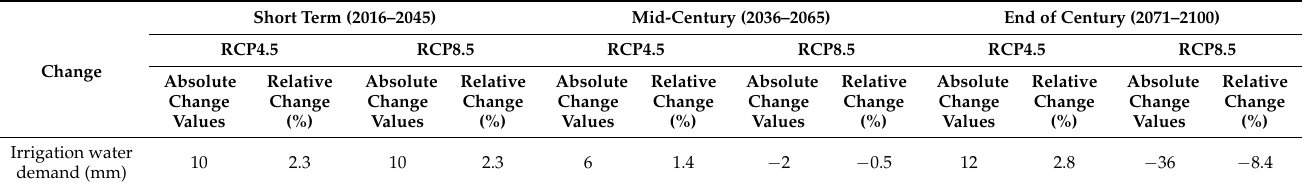
Table 4. Absolute and relative change in irrigation water demand, biomass, and grain yield for wheat based on average values from four GCMs relative to the reference period (1981–2010). Absolute values for irrigation water demand, grain yield, and biomass yield are in mm, kg/ha, and kg/ha, respectively. Relative values are expressed as